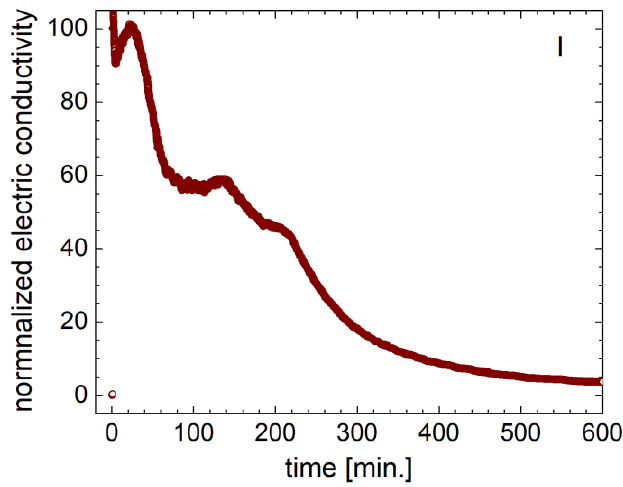
Figure 8. Normalized electric conductivity measurement for sample I with the smallest content of GO.